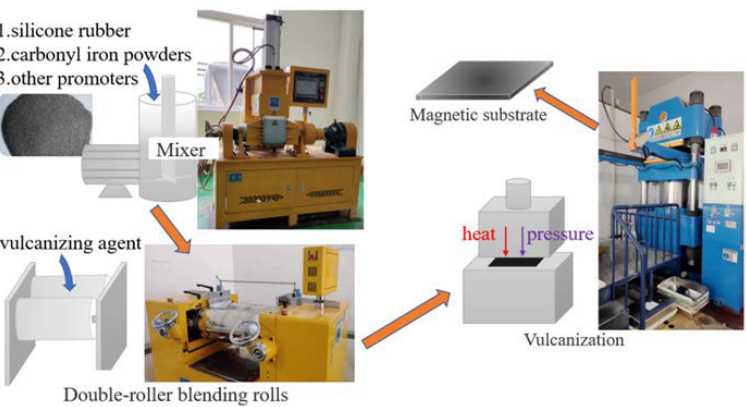
Figure 7. The preparation process of the magnetic substrates.